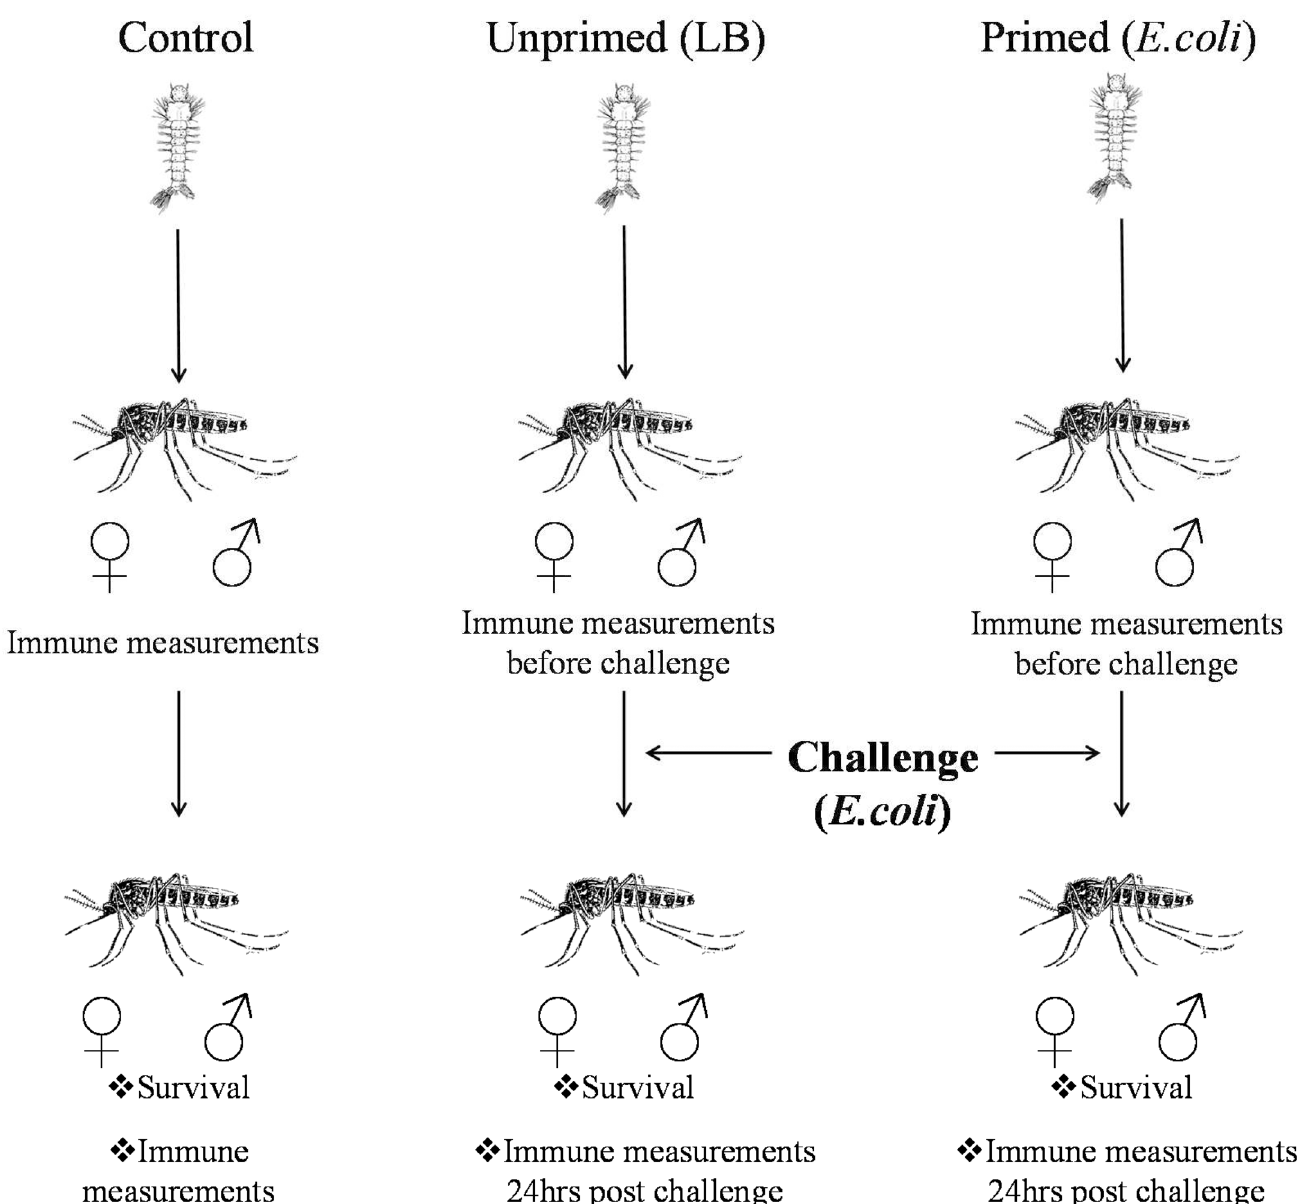
Fig 1. Experimental design. Induction of priming in fourth instar larva of Aedes aegypti against E . coli , and the measured parameters in adults. For both genders, parameters were recorded in adults both before the challenge and 24 h post-challenge. Survival was quantified after this challenge.